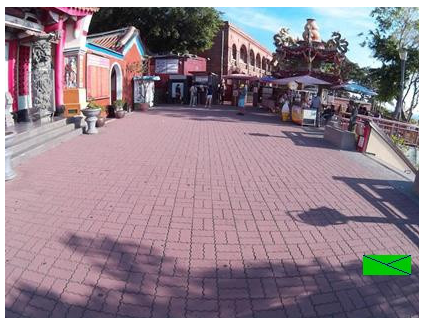
Figure 17. Shape “T cross” of thickness 1. Table 4. The testing of the “T cross” marker shape with uniform colors was carried out for 21 epochs with the interior images dataset. Marker